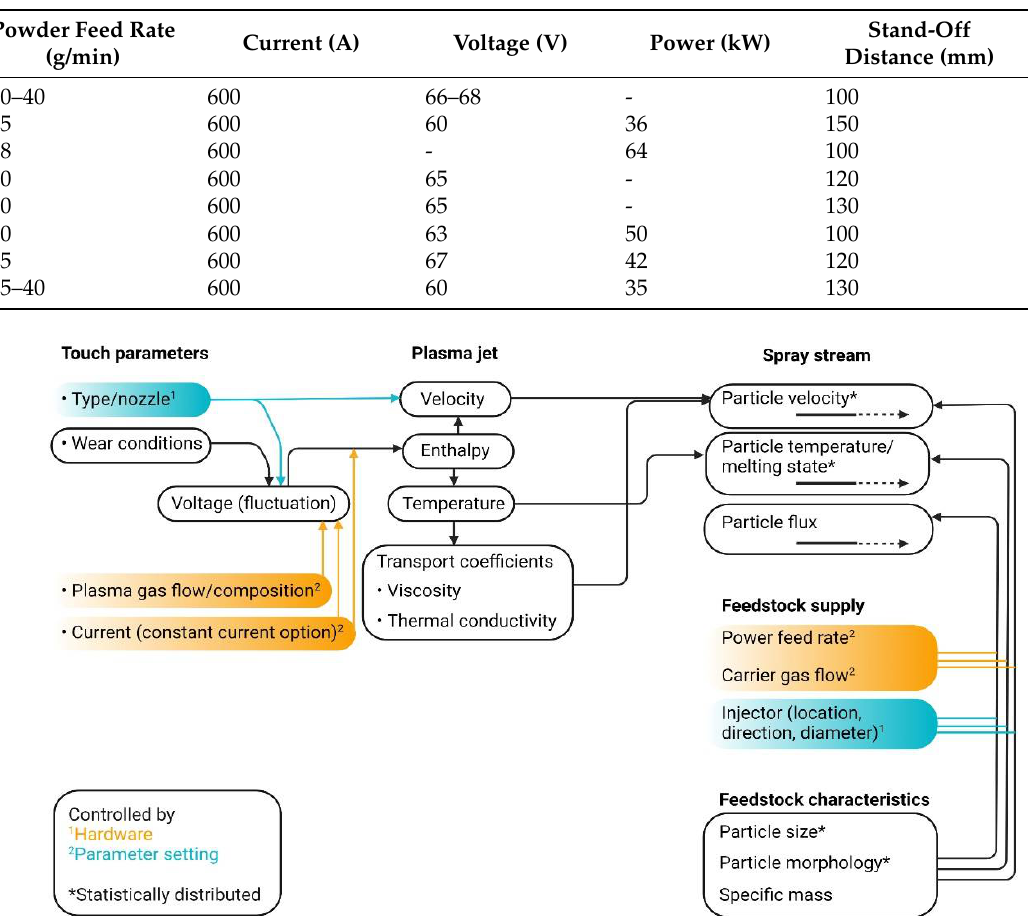
Table 1. The plasma spraying parametersfor the top coat’s first stage.